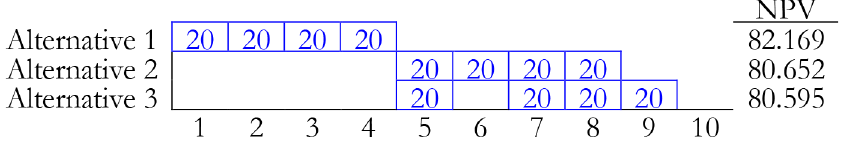
Figure 1. Calculating NPV in 3 execution alternatives of an activity